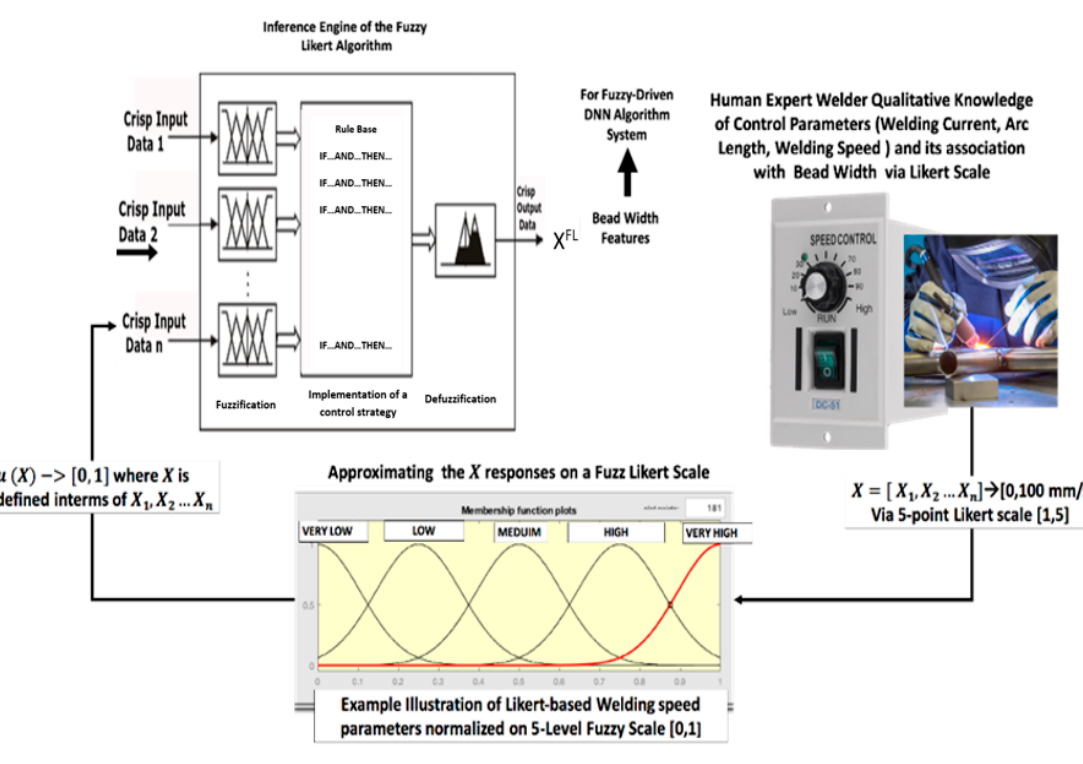
Figure 6. Fuzzy logic-based Likert Figure 6 . Fuzzy logic-based Likert inference.